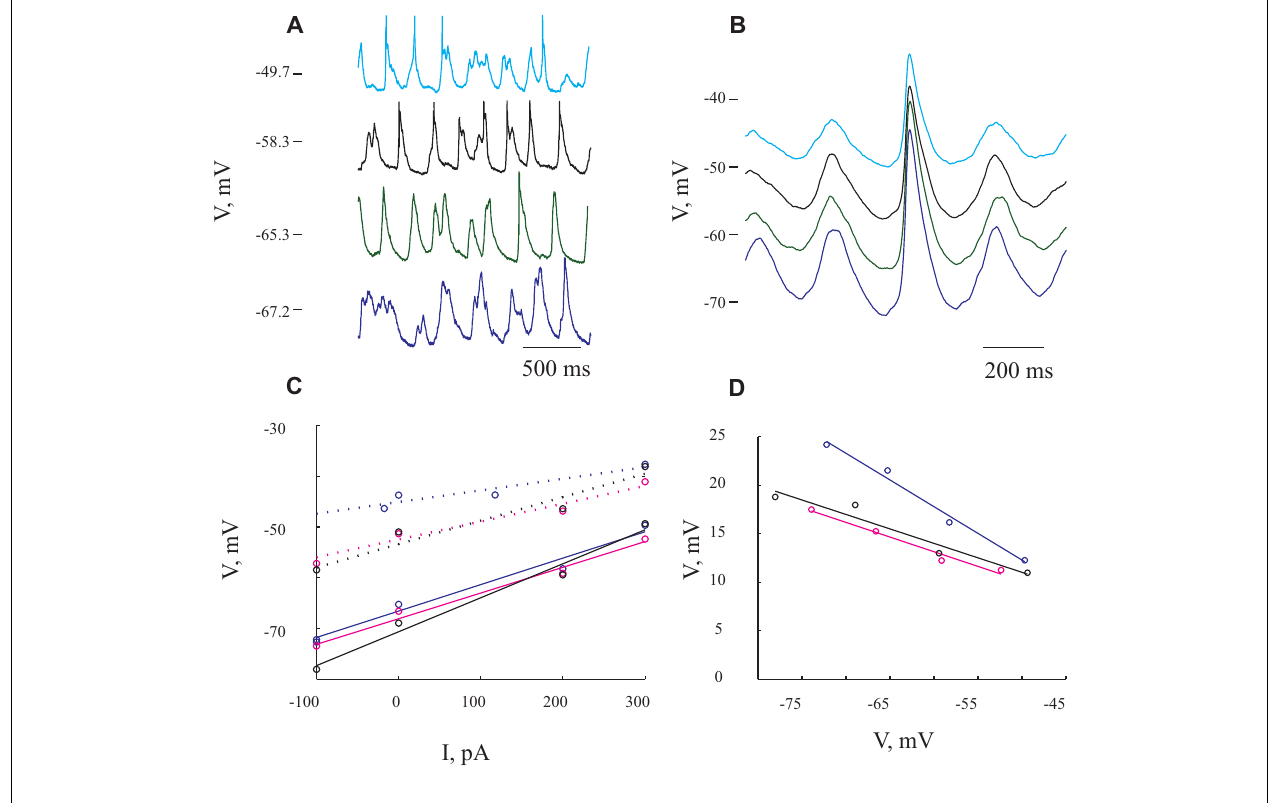
In black and magenta are I/V curves calculated from the histogram peaks (resulting in R in of 79 and 49 M (cid:2) for resting potential and GSP peak, respectively) and Gaussian fitting (resulting in R in of 50 and 35 M (cid:2) for resting potential and GSP peak) methods, respectively (see Materials and Methods). (D) GSP amplitude as a function of membrane potential. Note the steep decrease in GSP amplitude with depolarization (same colors as in C ).The expected reversal potential of the GSPs is calculated by extrapolation of the curves to intersect with the abscissa. All panels refer to data from the same cell.